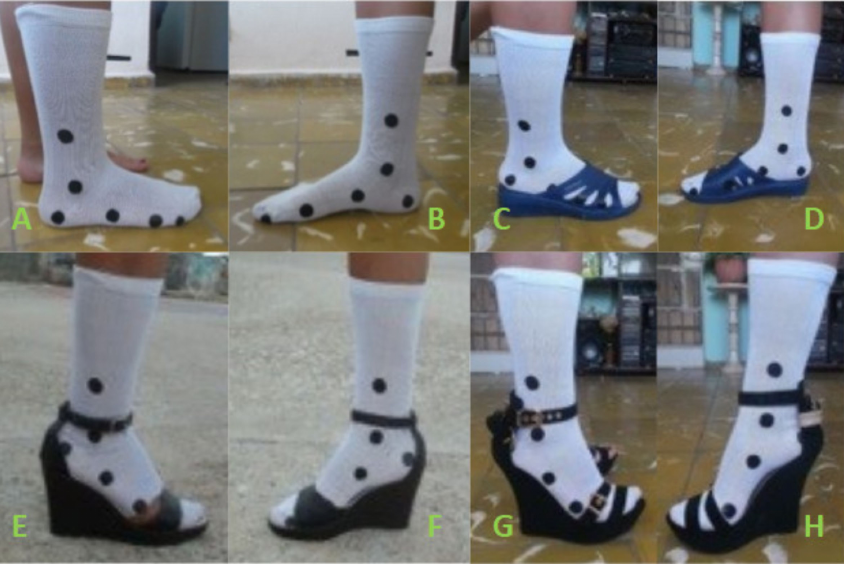
Figure 3. Location of markers on the lateral foot side ( A ) barefoot; ( C ) 2 cm heels; ( E ) 6 cm heels; ( G ) 10 cm heels) and on the medial foot side ( B ) barefoot; ( D ) 2 cm heels; ( F ) 6 cm heels; ( H ) 10 cm